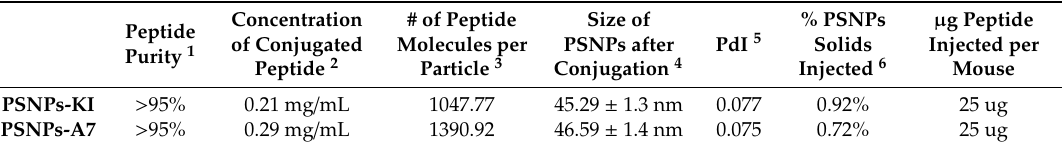
Table 2. Characterization of peptides conjugated to the